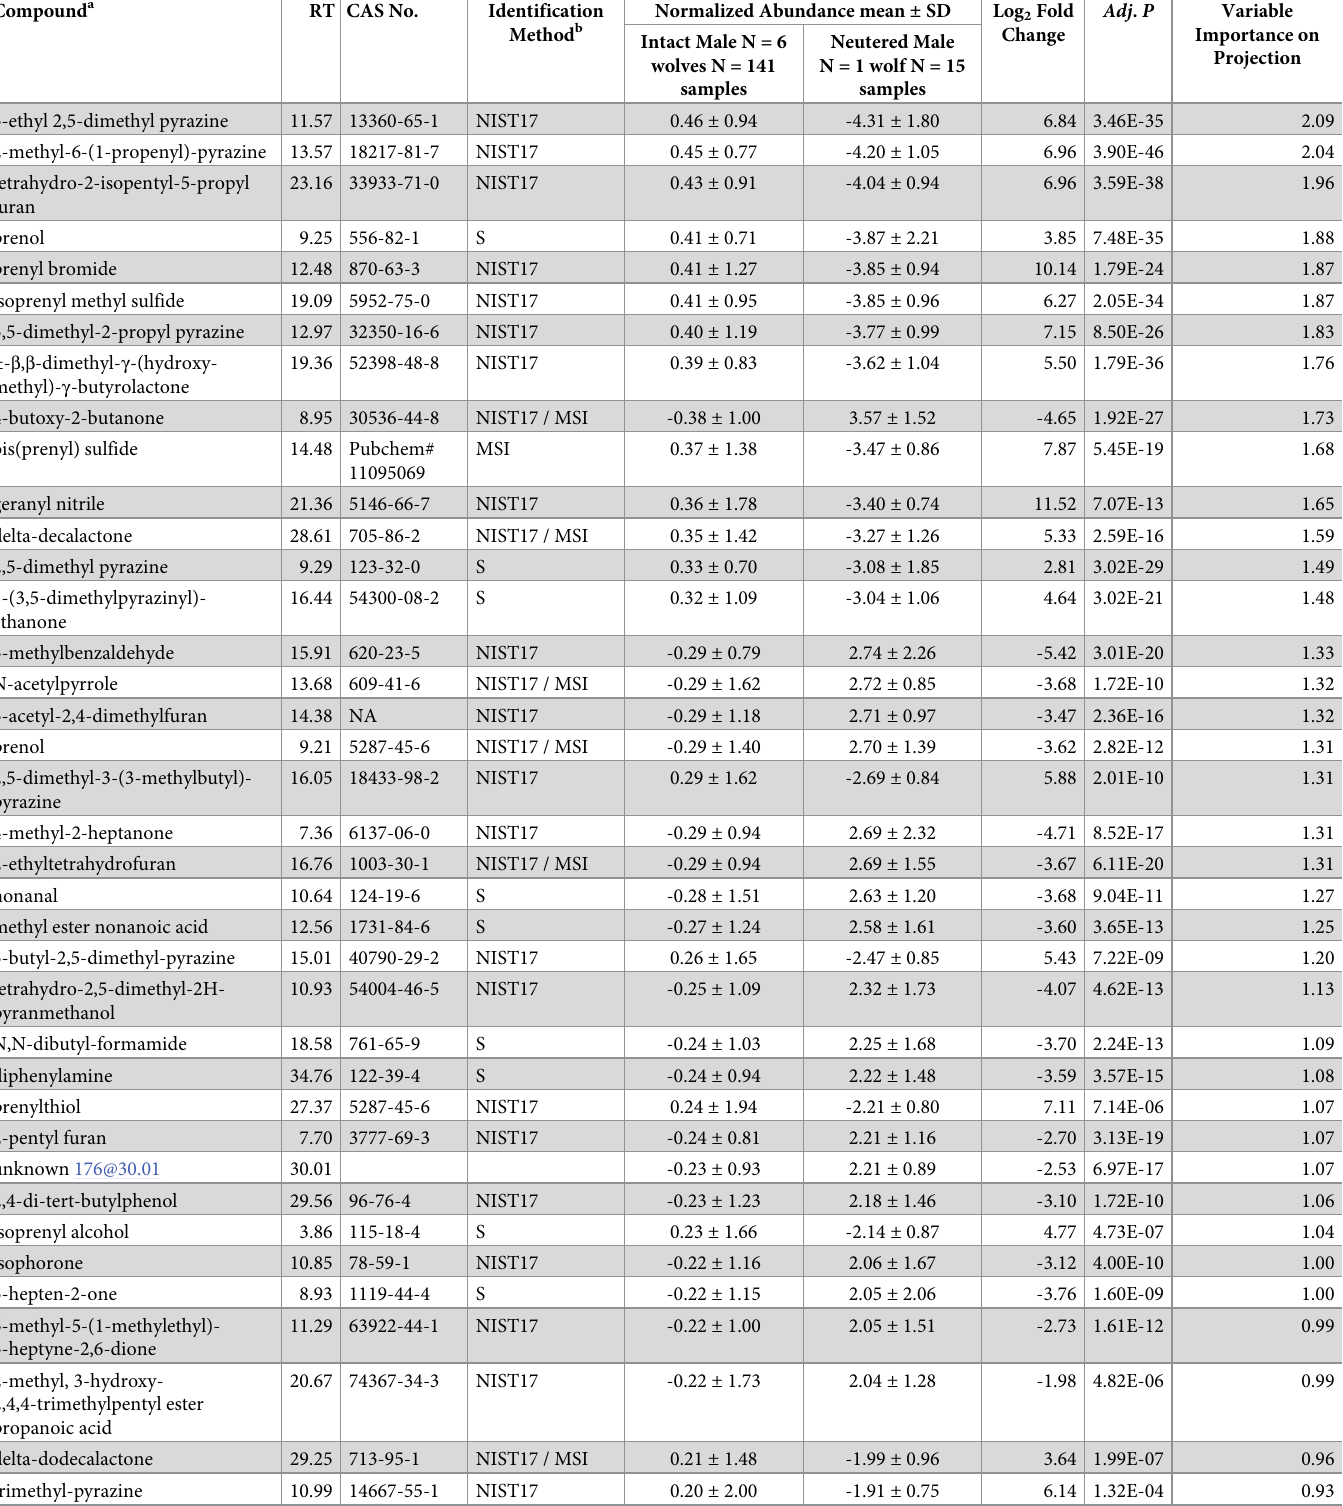
Table 4. VOCs that differed significantly between intact and neutered male maned wolf urine